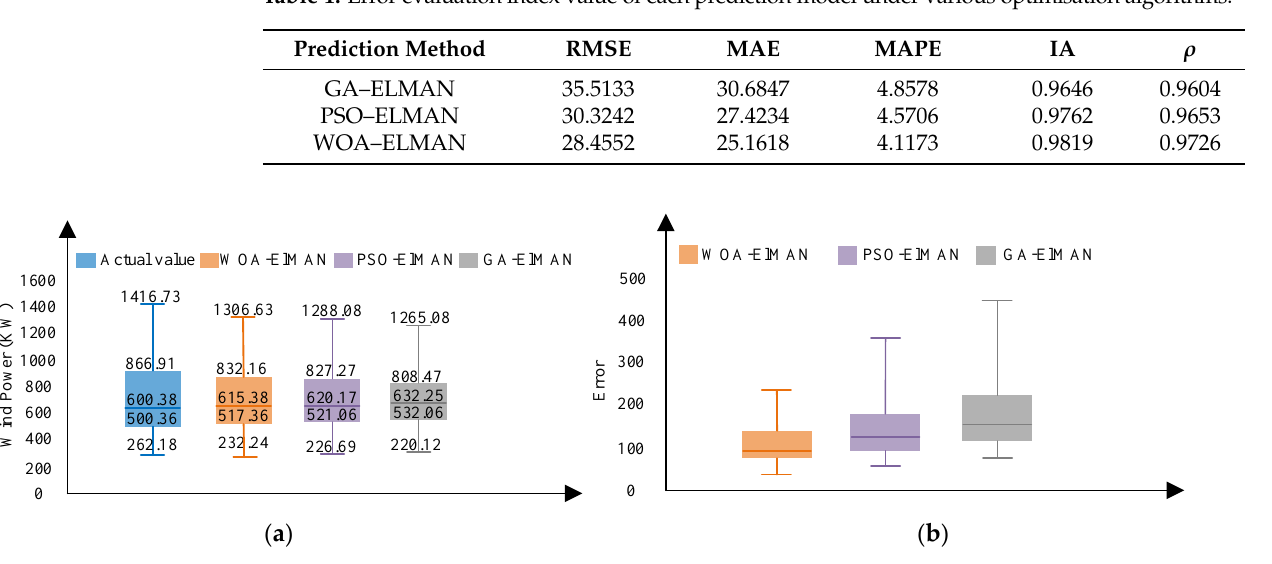
Figure 8. Comparison of statistical results of predicted values. Statistical results of ( a ) wind power prediction and ( b ) prediction error.